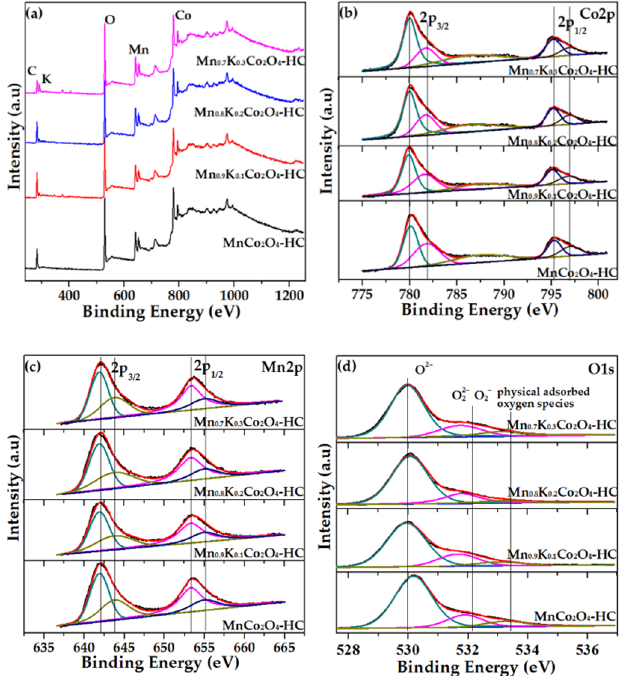
Figure 10. XPS Spectra of Mn 1 − n K n Co 2 O 4 -HC catalysts: surface wide spectrum ( a ), Co2p ( b ), Mn2p ( c ) and O1s ( d ).